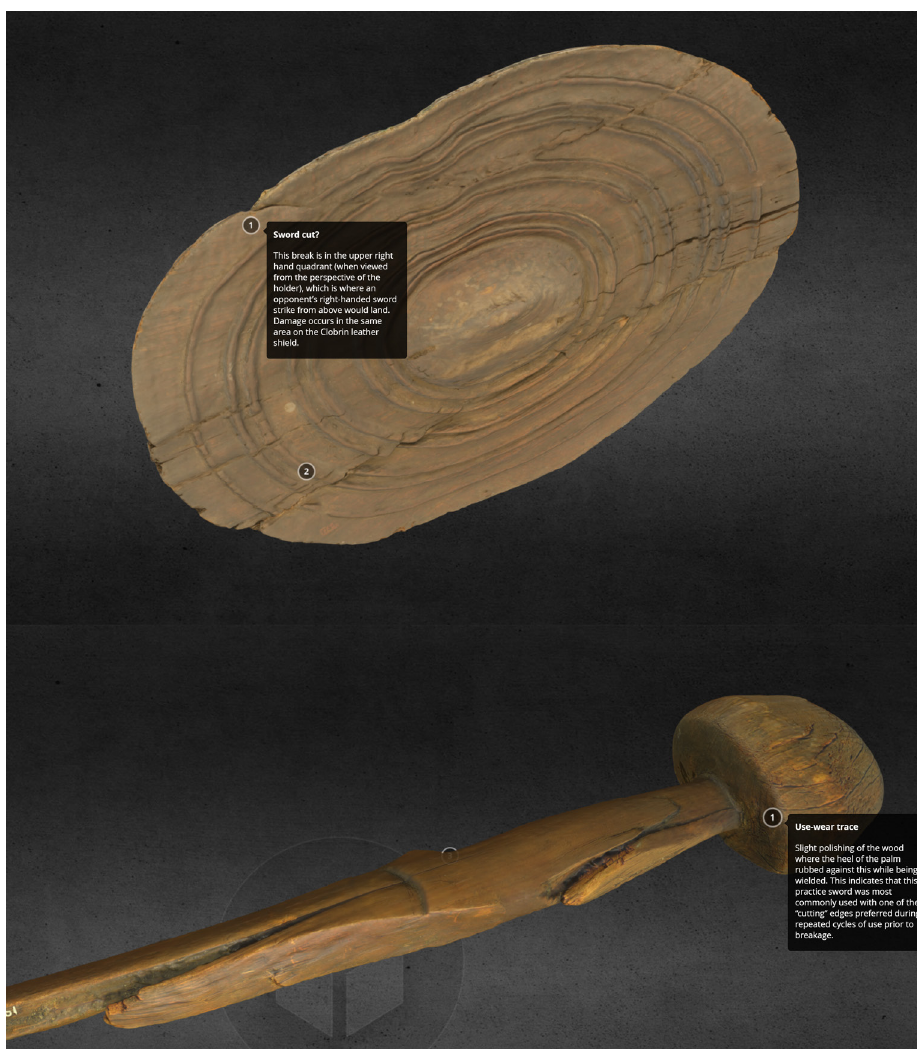
Figure 4. 3D model of the Bronze Age wooden shield from Annadale, Ireland (https://skfb.ly/NYyA), with annotations and wooden sword from Cappagh, Ireland with annotations (https://skfb.ly/TNRG). Models by M. Wisniewski and B. Molloy and by M. Milić and models generated using images taken by kind permission of the National Museum of